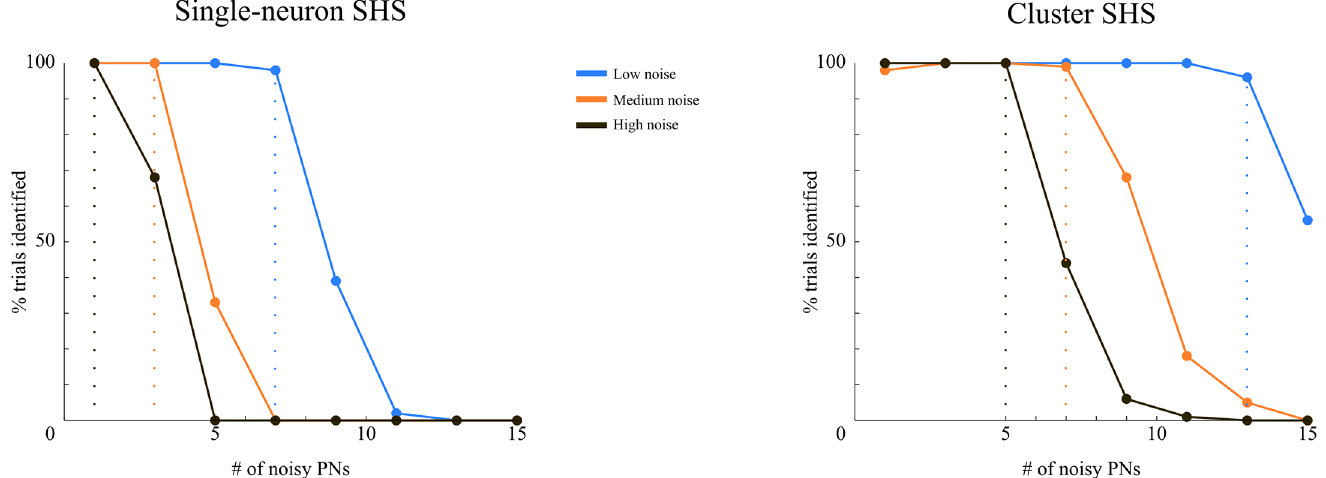
Fig 10. Performance of the model with noisy PN input. The performance of our model was measured in terms of displaying the expected sequence in response to the input while a number of PNs that connect to a single KC display large amounts of noise. Three noise levels were used (different colors); with high noise (SNR of only 1), the activity of a PN is mostly noise-driven, because the fluctuations due to noise are comparable to activity of the noise-free PNs. With an SNR of 2 (called here low noise), the noise variations are about one third of the maximum noise-free PN activity. Medium noise had an SNR of 1.5. On the x-axis, we plotted the number of noisy PNs; on the y-axis, the percentage of trials in which the KCs displayed the correct representation (100 trials for each number of noisy PN/noise combination). Left: performance of an inverted Single-neuron SHS generative model. We used a modified version of our generative model, in which single KCs, as opposed to clusters of KCs, are activated sequentially. This is then projected to the PNs as described for our proposed model and inverted with the described unscented Kalman filter. Right: performance of proposed model with Cluster SHS. The large differences in the performance of the two models can be attributed to the within-cluster lateral input that the KCs receive (i.e. intelligent coincidence detector) in the Cluster SHS model: The performance of the single-neuron SHS model degrades for smaller number of noisy PNs, for all noise levels. In particular, for high noise rather small numbers of noisy PNs lead to poor